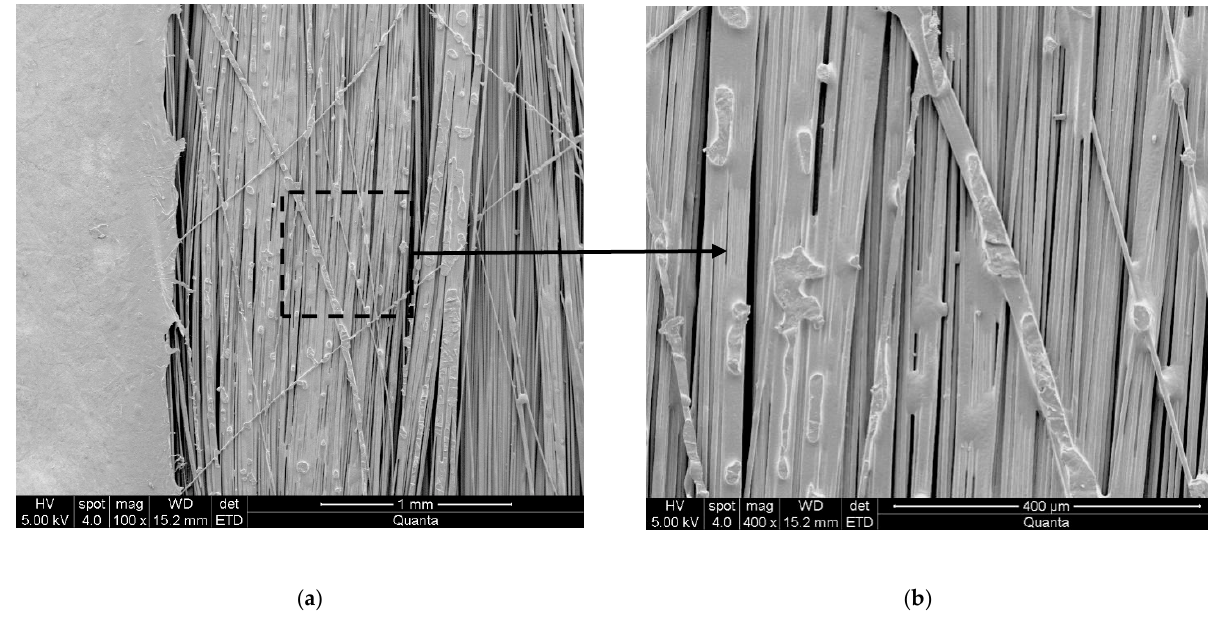
Figure 11. ( a ) SEM image of the weld. ( b ) Magnification of the dotted area. Circles in ( b ) indicate areas of molten nanofabric coating the carbon fiber tows.